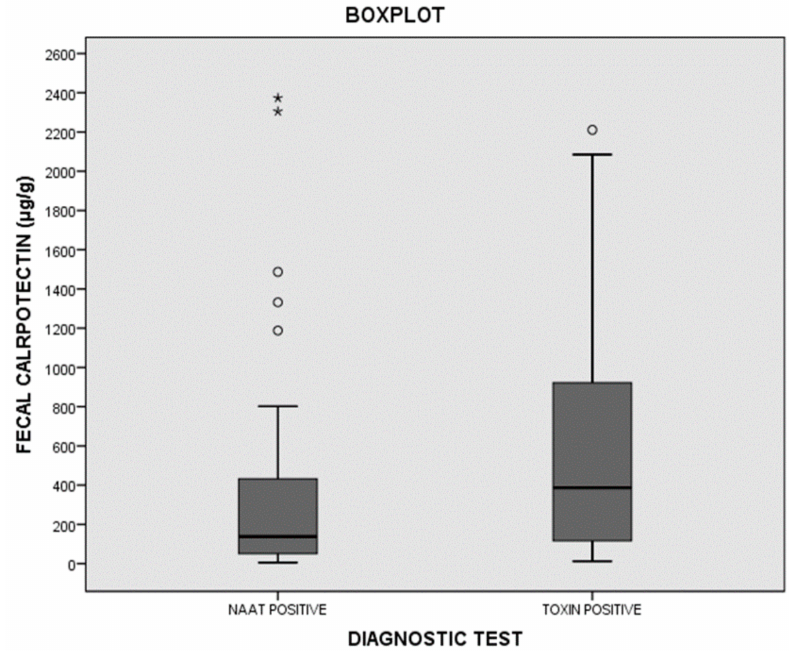
Figure 3. Distribution of fecal calprotectin (fCP) among toxin-positive and toxin-negative /NAAT- positive cases. * maximum value in the data, ◦ potential